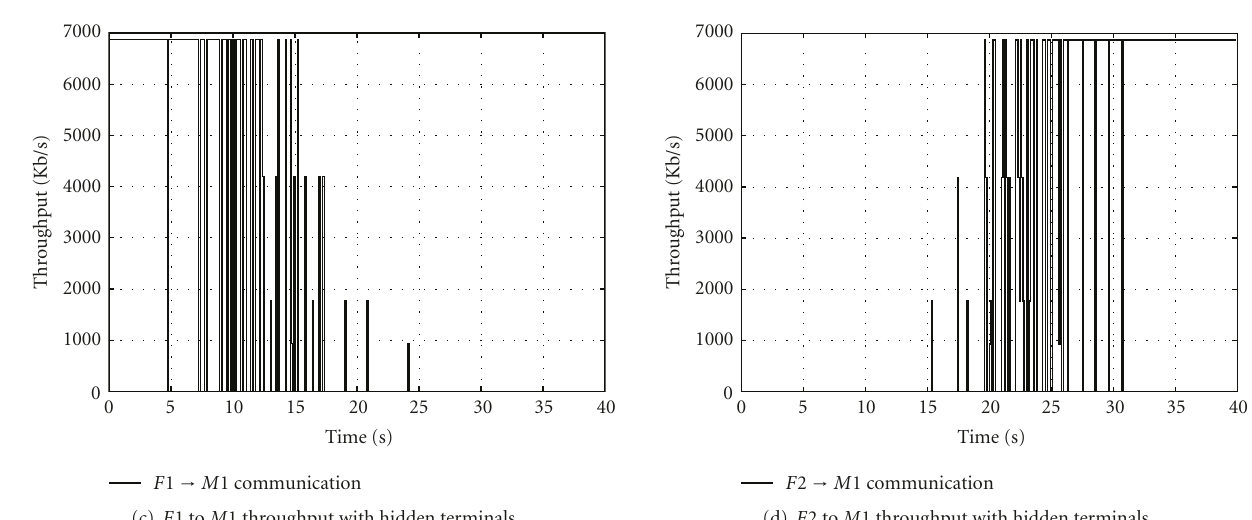
Figure 18: Two simulated possibilities of a hidden terminal